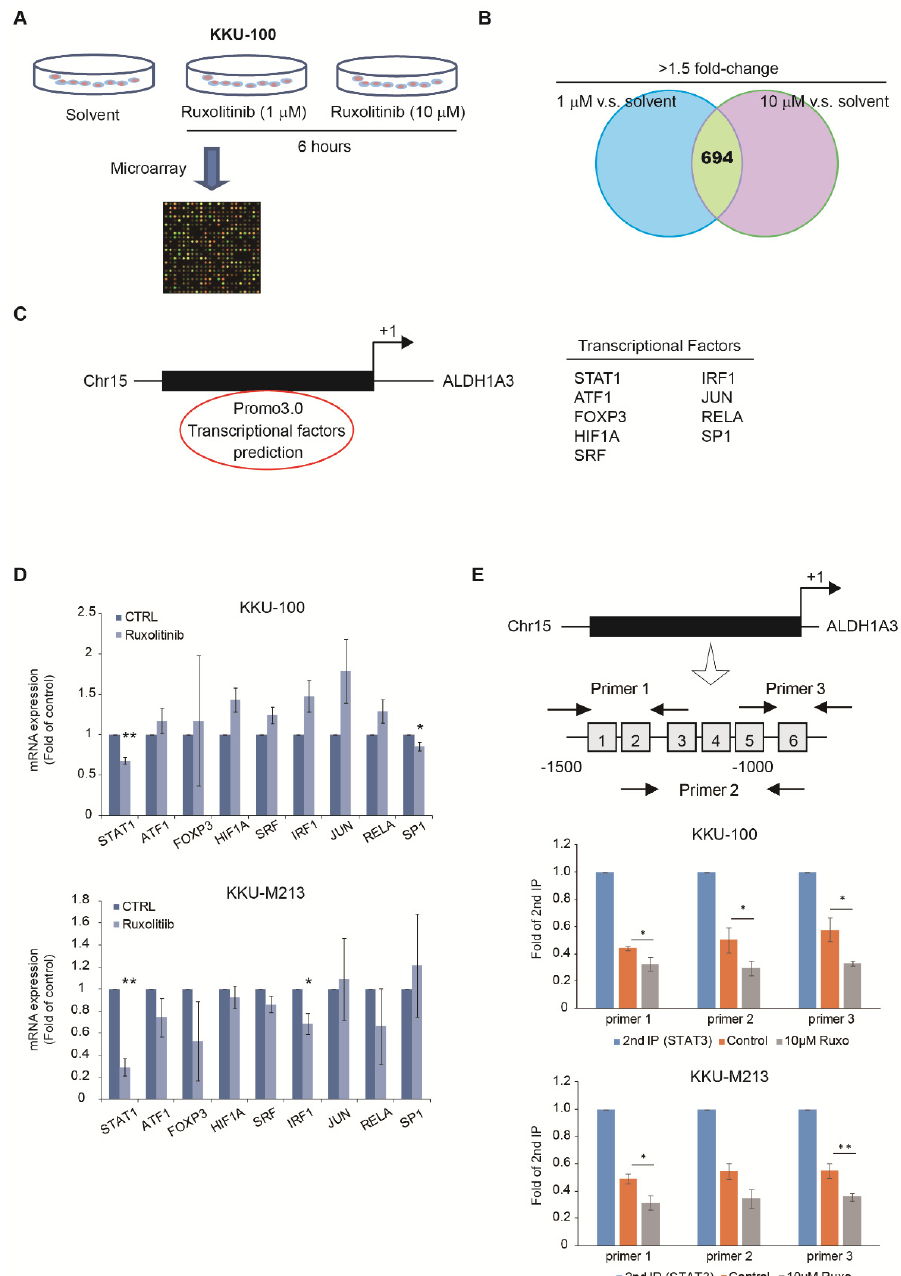
Figure 3. Effects of ALDH1A3 via functions of STAT1 and STAT3. ( A ) The gene signatures of KKU-100 cells cultured for 6 h with or without low doses (1 μ M) or high doses (10 μ M) of ruxolitinib were analyzed using Ingenuity Pathway Analysis (IPA). ( B ) The scheme of different gene signatures of KKU-100 cells was validated by IPA. ( C ) The nine putative transcription factors that correlated with ALDH1A3 and ruxolitinib were predicted using the PROMO 3.0 software. The lists of transcription factors are listed in the right panels. ( D ) Total RNA (5 μ g) was isolated from the KKU-100 and KKU-M213 cells and subjected to RT–qPCR analyses to determine the mRNA levels of predicted transcription factors, including STAT1 , ATF1 , FOXP3 , HIF1A , SRF , IRF-1 , JUN , RELA , and SP1 . Data are the mean ± standard deviation of three independent experiments. * p < 0.05 and ** p < 0.01 compared with the respective control group by the Student’s t test. ( E ) Schematic of the upstream promoter region of the ALDH1A3 gene with six predicted STAT1-binding sites (1–6). The region amplified in the re-ChIP assay is indicated by arrows (primers 1–3). The DNA samples represent yields of the secondary immunoprecipitation (second IP), control, and drug-treated groups (anti-pSTAT1 and p-STAT3). Data are the mean ± standard deviation of three independent experiments. * p < 0.05 and ** p < 0.01 compared with the respective control group by the Student’s t test.